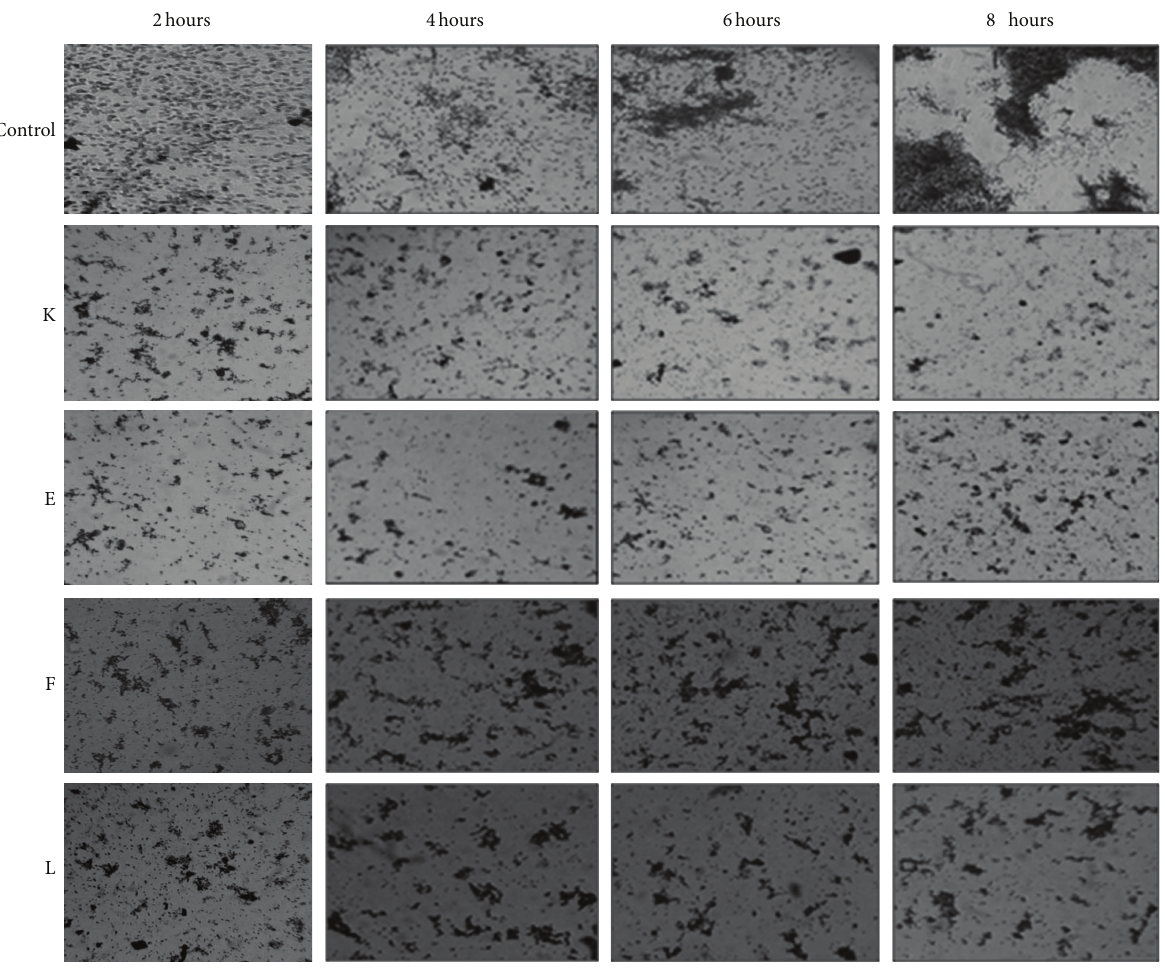
Figure 4: Antibiofilm activity of selected